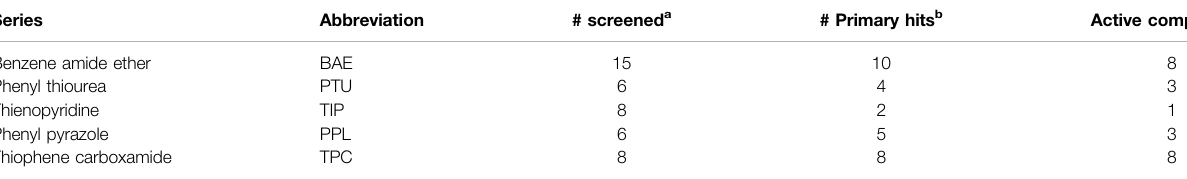
TABLE 3 | Series selected for follow-up.